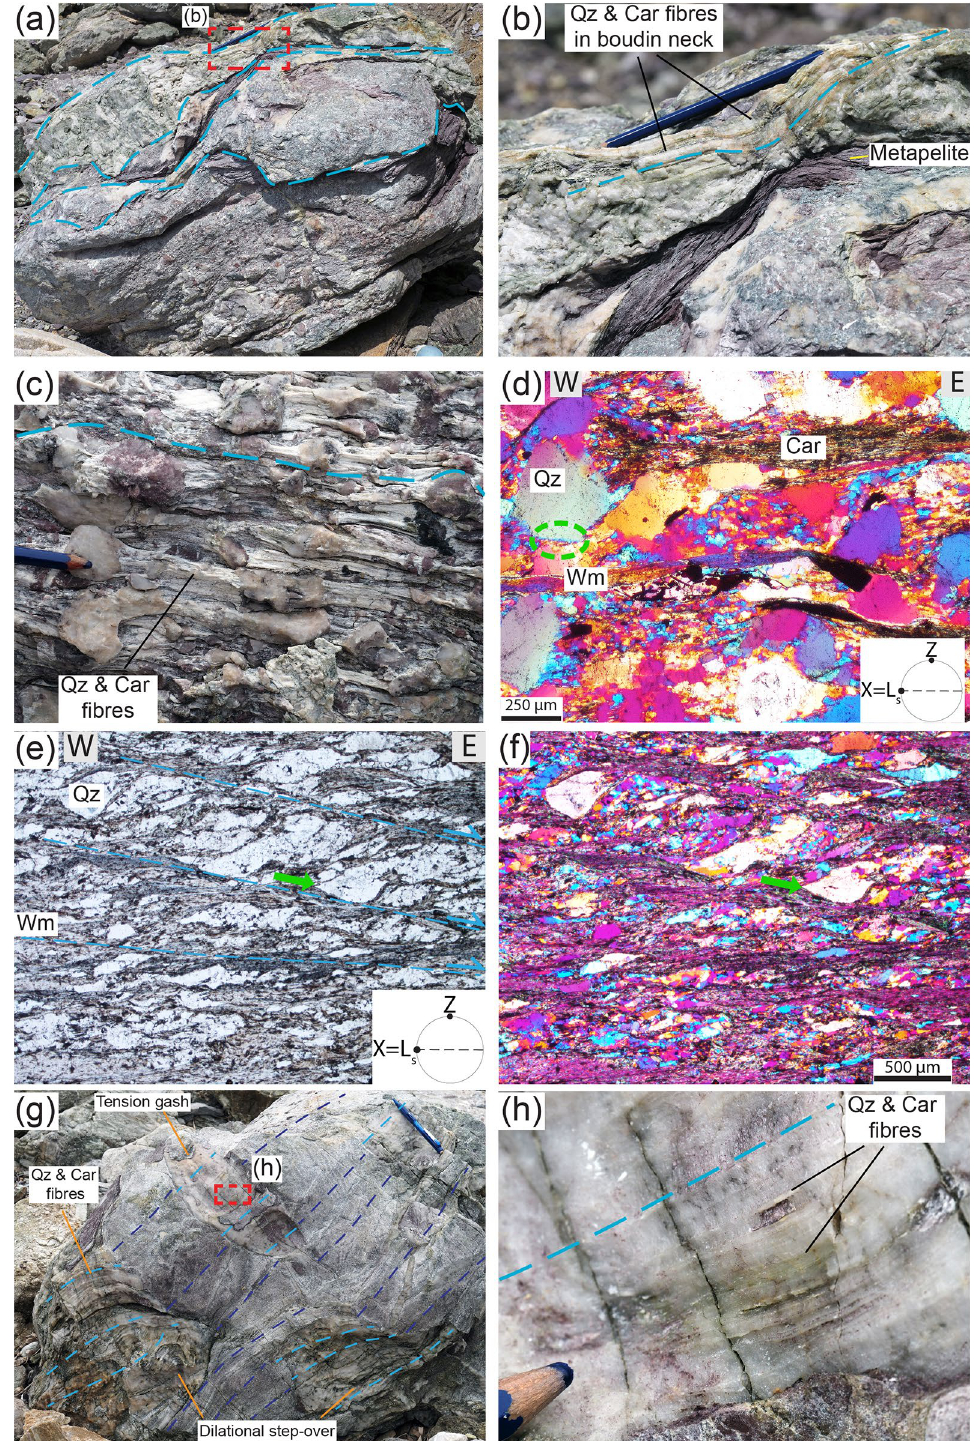
Figure 2. Brittle and ductile deformation features affecting the studied lithotypes. ( a ) Metaconglomerate boudins within metapelite layers; the contact between the two lithotypes are indicated by the dashed light blue lines. ( b ) Quartz and carpholite fibres grow iso- oriented in boudin necks (dashed light blue lines). ( c ) Metaconglomerate with rounded quartz clasts, from pink to white in colour, displaying quartz and carpholite fibres growing in the asymmetric strain shadows of the clasts. ( d ) Thin section photo with detrital quartz clasts wrapped by the blueschist facies foliation producing asymmetric pressure shadows marked by carpholite and white mica. The dashed green ellipsis indicates two compenetrated quartz clasts. Crossed-polarized light with gypsum plate inserted. ( e , f ) Thin section photos of metaquartzarenite with detrital quartz clasts sheared by blueschist facies top-to-the-E extensional crenulation cleavage (light blue dashed lines) marked by white mica. Detrital quartz clasts are overgrown epitaxially in the asymmetric pressure shadows (green arrow). Plane-, crossed-polarized light with gypsum plate inserted, respectively. ( g ) Metaquartzarenite block containing tension gashes and dilational step-overs sealed by quartz and carpholite fibres growing parallelly to the blueschist facies foliation. Dashed light blue lines indicate the orientation of the fibres, dashed dark blue lines the trace of foliation. ( h ) Detail of tension gash with quartz (white) and carpholite (greenish-yellowish) fibres, some centimetres